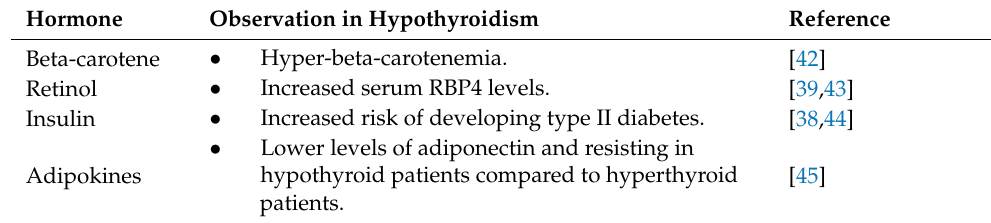
Table 4. Intersection of hypothyroidism, vitamin A signalling, and metabolic components.